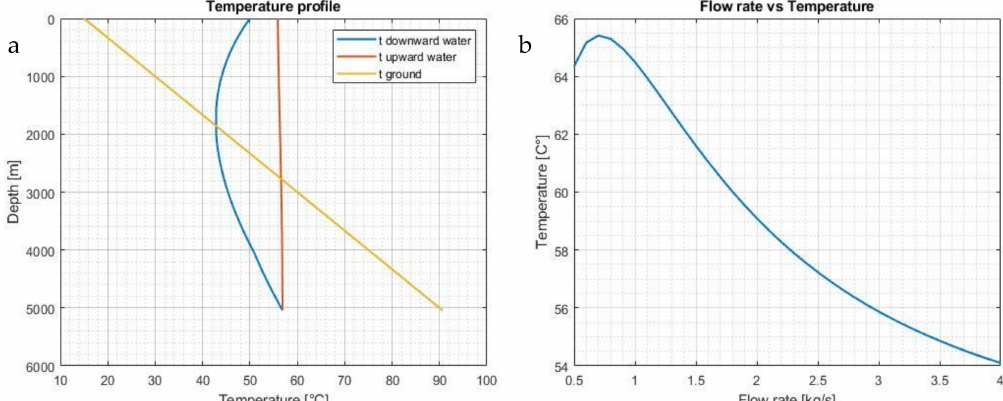
Figure 8. ( a ). Temperature profile associated with the coaxial WBHE configuration considering the site-specific stratigraphy of Tempa Rossa 1D well. ( b ) Wellhead temperature behaviour as the flow rate changes.